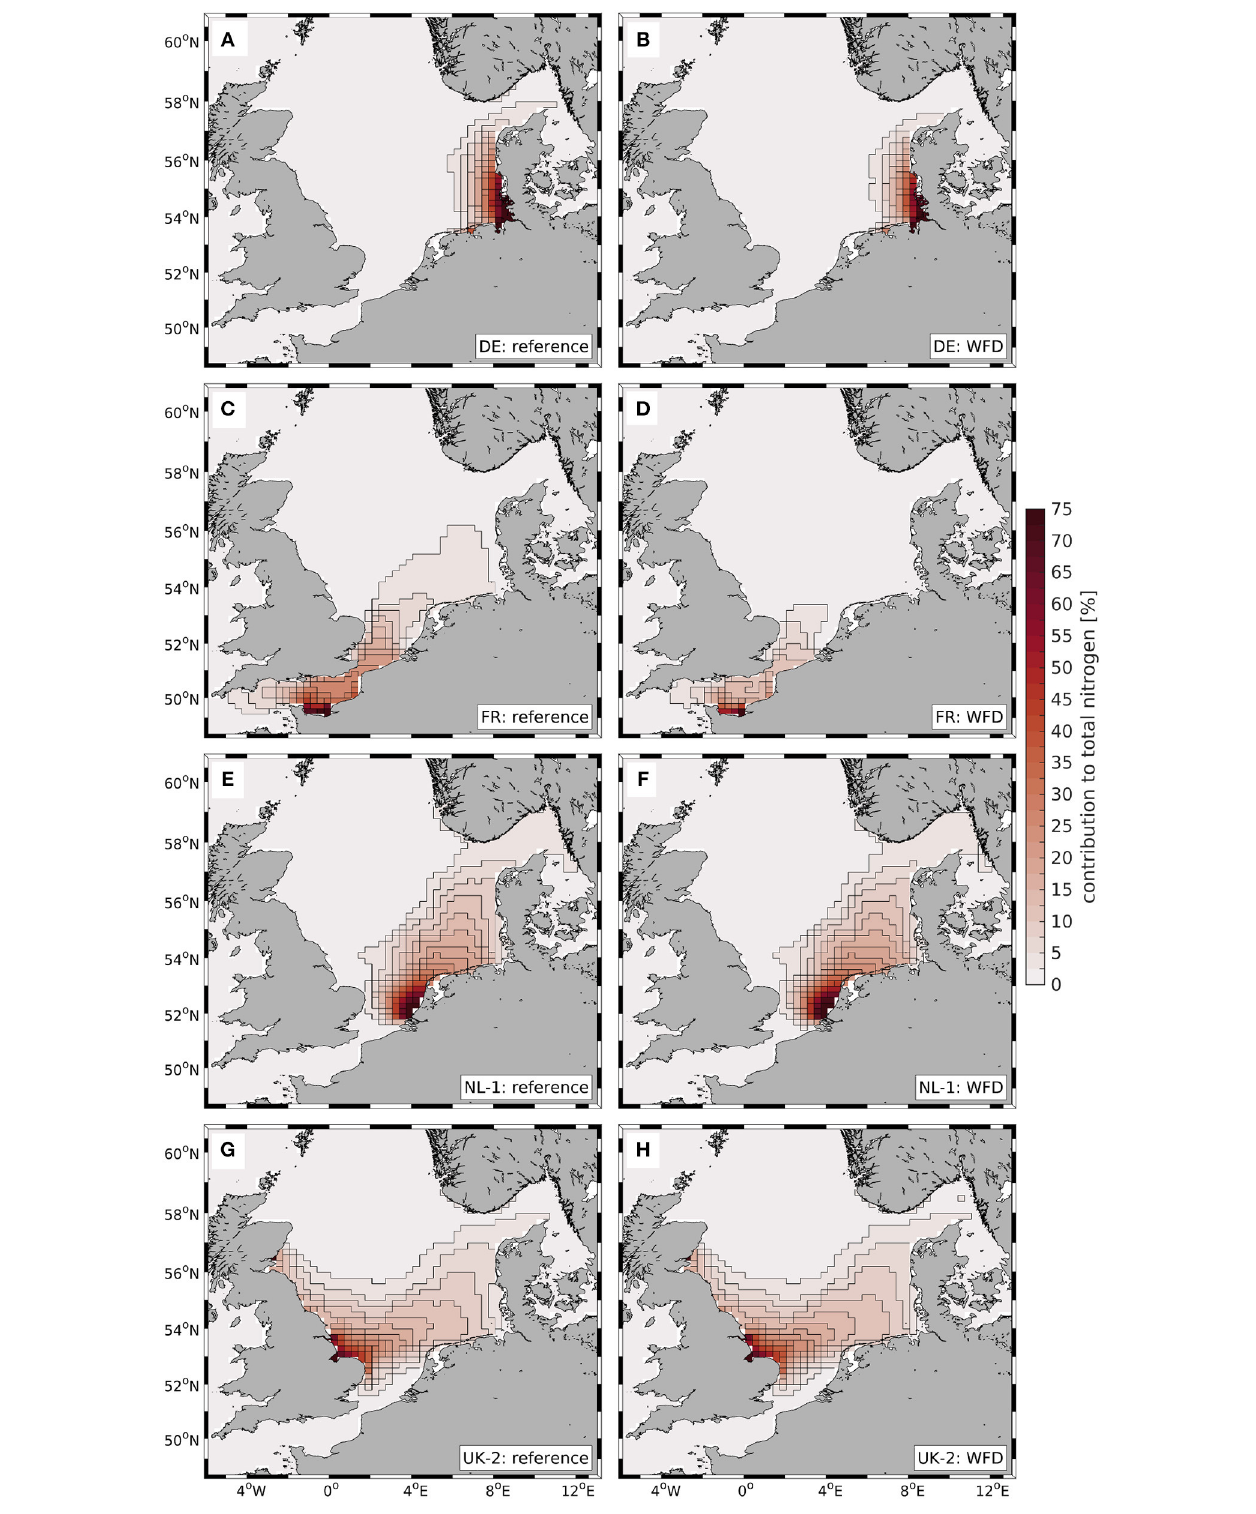
FIGURE 4 | Maps of average relative contributions to TN by selected river source groups for (left) the reference simulation and (right) the WFD reduction scenario during 2006–2014: (A,B) German Rivers (DE), (C,D) French rivers (FR), (E,F) first group of Dutch rivers (incl. Rhine and Meuse; NL-1), and (G,H) rivers on British east coast (UK-2). Same color scale for all